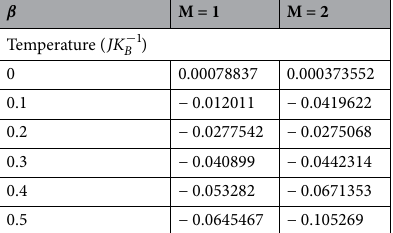
Table 1. Estimation of Temperature with changing M in expulsive-BOL